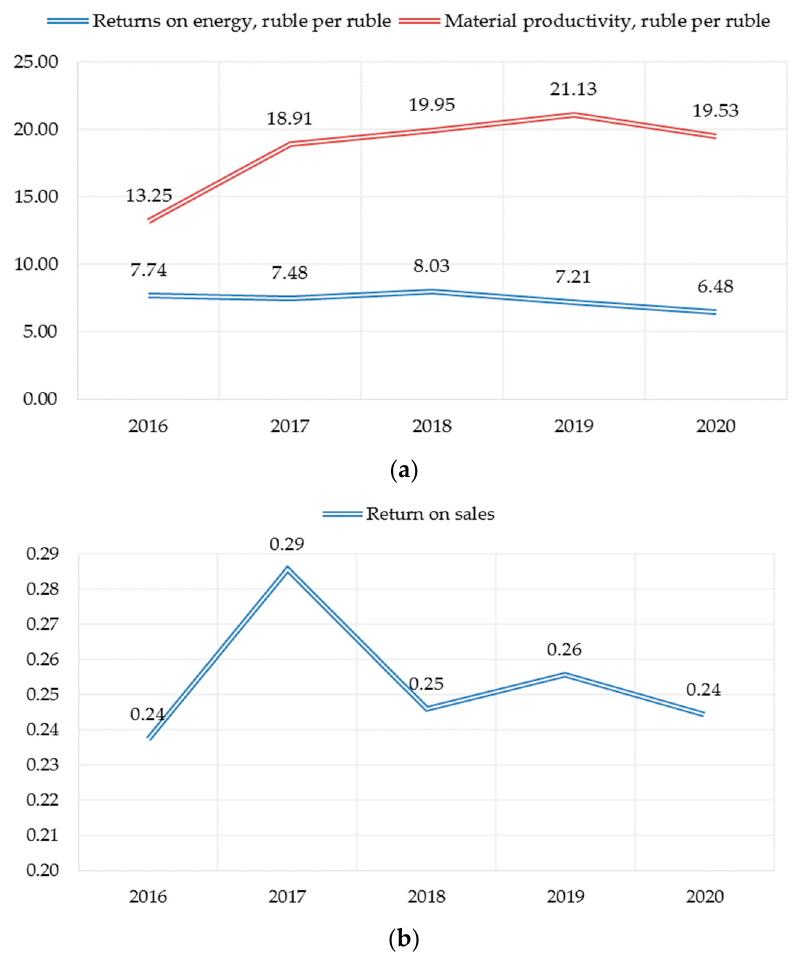
Figure 1. Sub-indices of PJSC «Nizhnekamskneftekhim economic sustainability factor assessment»: ( a ) Energy and materials efficiency indicators, ruble per ruble; ( b ) Return on sales indicator (coefficient).